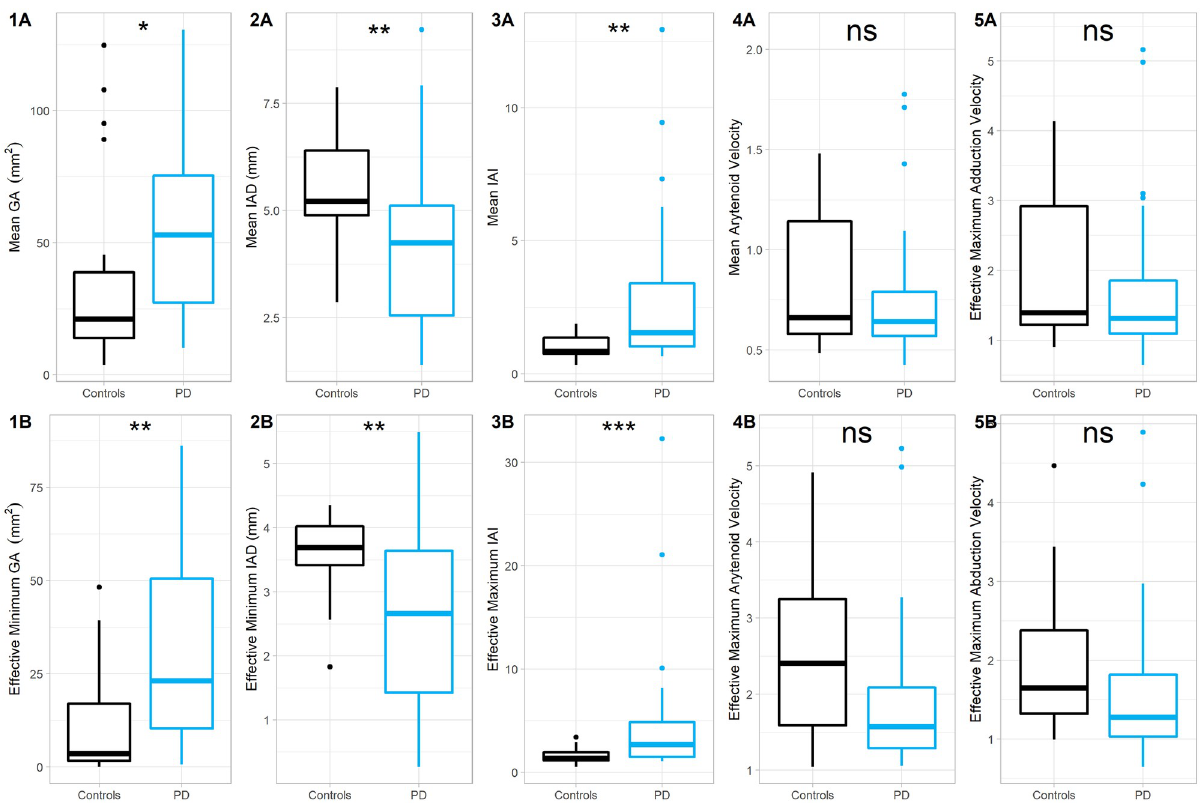
Fig 2. Comparison of the laryngeal measures during vocalization between pwPD and controls. Boxplots comparing measures of laryngeal dynamics in participants with Parkinson’s disease (blue boxes) against controls (black boxes). (1-3A) Comparison of the means of the GA , IAD and IAI during the period of vocalization. (1-3B) Comparison of the values of the laryngeal measures at maximal vocal fold adduction, corresponding with the effective minimum GA , effective minimum IAD and effective maximum IAI . The mean and effective maximum velocities of the arytenoids is assessed in (4A) and (4B) respectively, calculated by assessing the extent of movement of the arytenoids between successive 100 ms volumes. Sub-analysis of the maximal � ! � ! velocities by the direction of vocal fold movements is shown in (5A) (adduction; adv ) and (5B) (abduction; abv ). ns p > 0.05; � p < 0.05; �� p < 0.01; ��� p < 0.001.